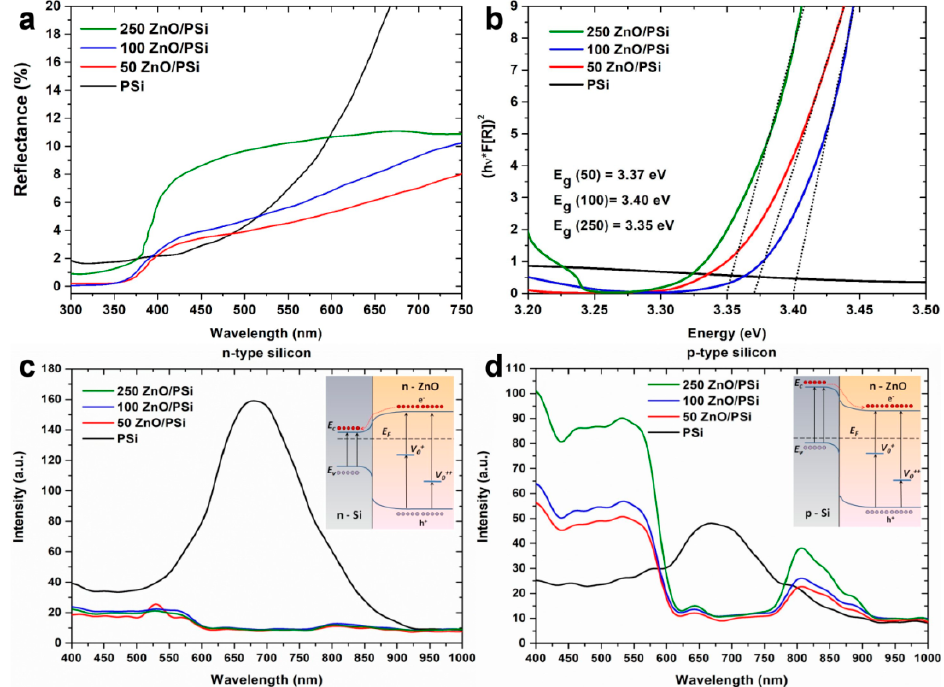
Figure 4. Optical properties of the fabricated PSi/ZnO nanocomposites: ( a ) diffuse reflectance spectra of PSi/ZnO nanocomposites; ( b ) absorption edges and corresponding energy band gap values; photoluminescence spectra for ( c ) n-PSi/ZnO and ( d ) p-PSi/ZnO nanocomposites. The energy band diagrams of corresponding excitation mechanisms are depicted in the insets.